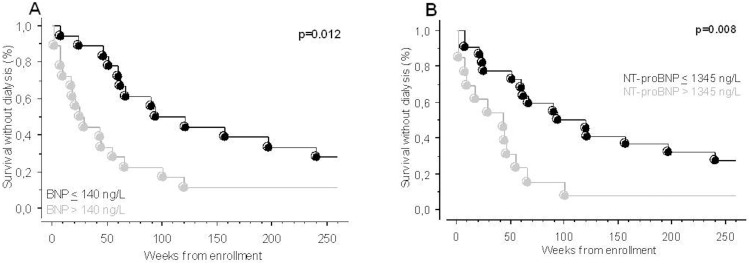
Kaplan Meier survival curves showing the association between survival and A) BNP above and below cut-off after 5 years follow-up. B) NT-proBNP above and below cut-off after 5 years follow-up. The difference between the groups was determined using the log-rank test.